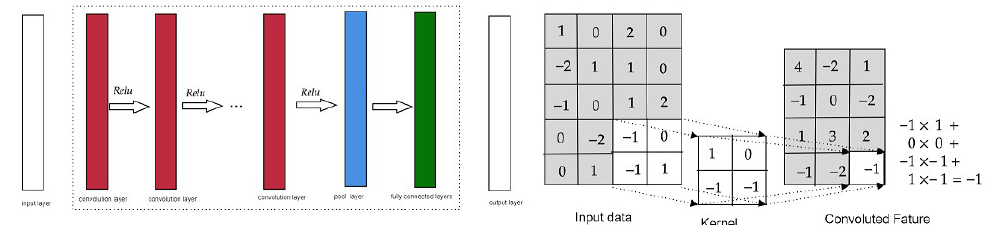
Figure 6. The left-hand side is the general CNN architecture, and the right-hand side is the convolu- tional operation.